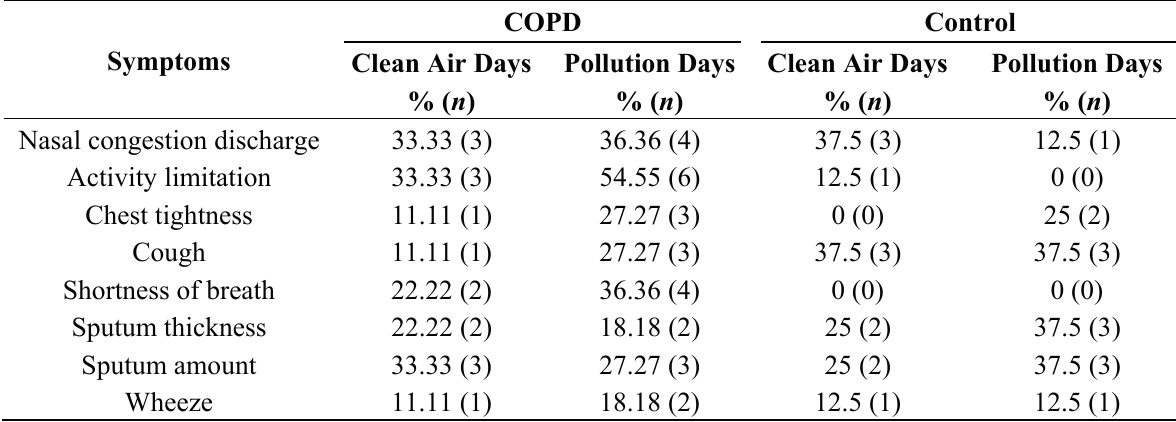
Table 7. Percent of patients reporting worsening symptoms on pollution or clean air quality